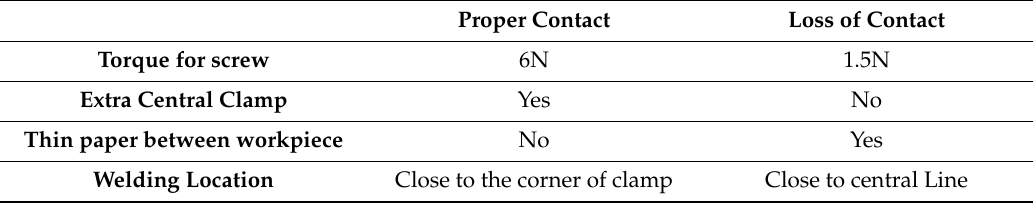
Figure 2. Setup for various contact conditions during welding: ( a ) proper contact; ( b ) contact with a gap between metal sheet layers. Table 2. Parameter design for generating proper and improper contacts.